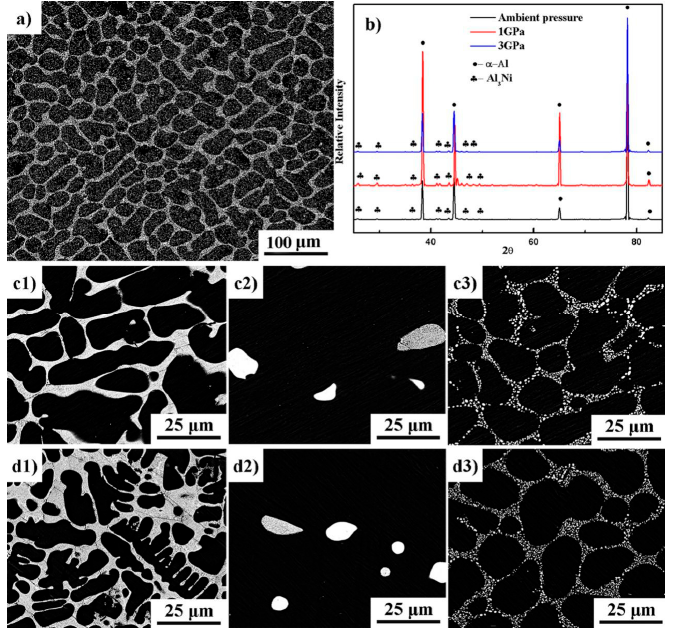
Figure 3. The microstructure and phase composition of Al - 1.5 wt%Ni alloy solidified under different pressures: ( a ) ambient pressure; ( b ) phase composition; ( c1 – c3 ) 1 GPa; ( d1 – d3 ) 3 GPa; ( c1 , d1 ) fully melted area; ( c2 , d2 ) mushy zone; ( c3 , d3 ) non-melted region.